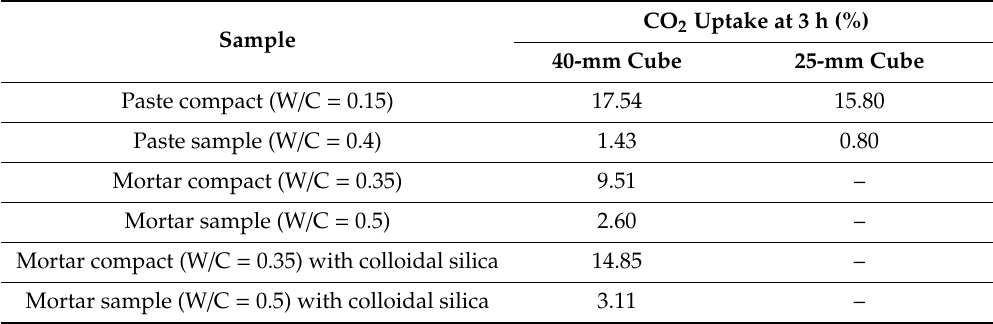
Table 4. Results of CO 2 uptake.